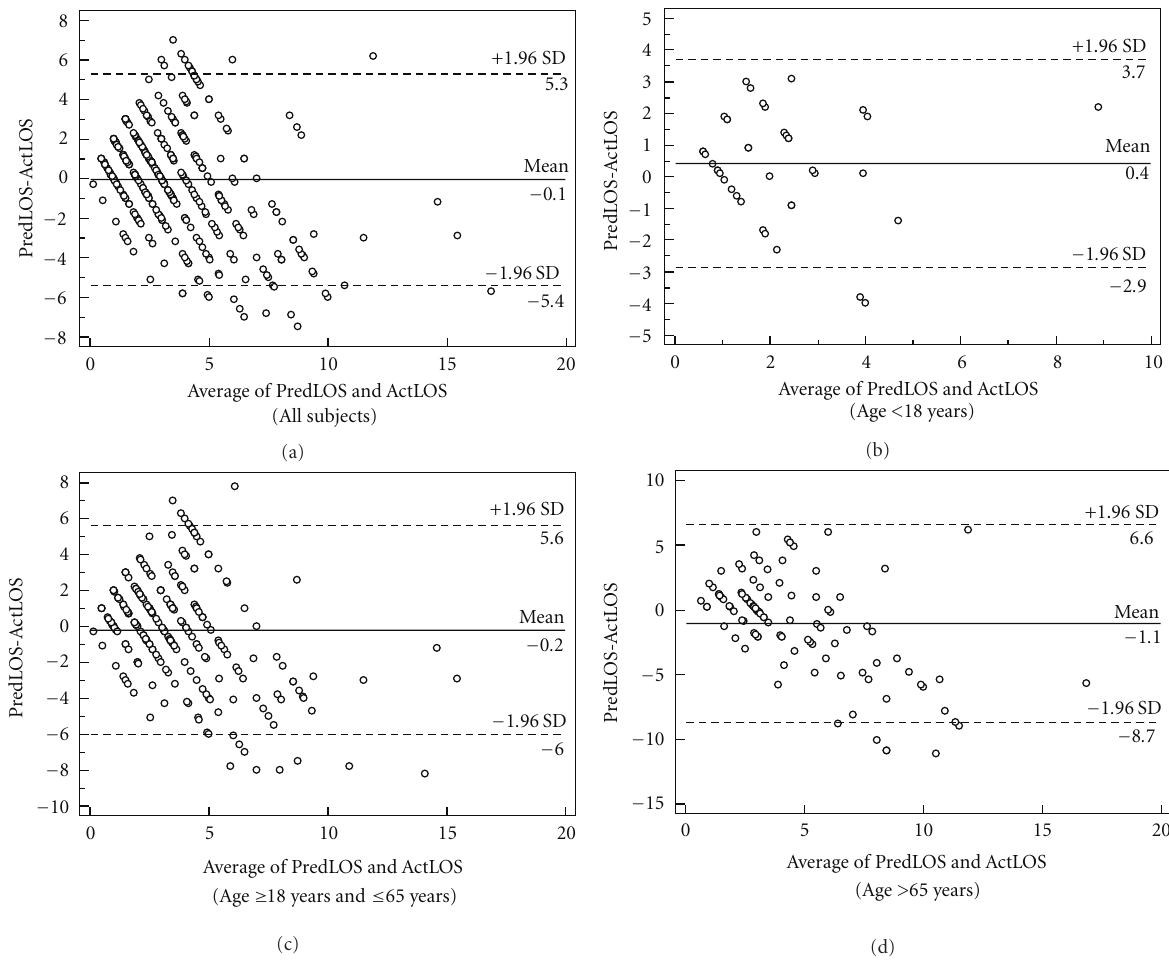
Figure 1: Bland-Altman analysis of predicted and actual LOS di ff